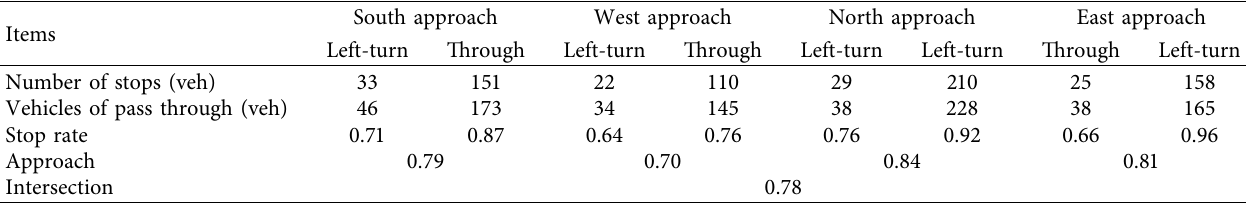
Table 8: Stop rate of the Hongqi Street and Huaihe Road intersection after optimization.